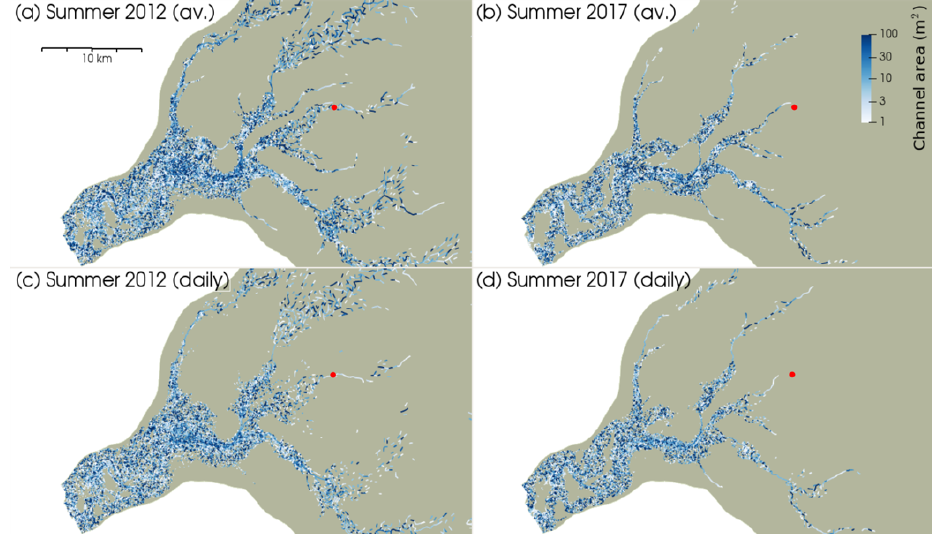
Figure 5. Summer channel network of Store. (a) SummerAverage12 model run; (b) SummerAverage17; (c) SummerDaily12; (d) Sum- merDaily17 (red dot shows S30 study site from Young et al., 2019). All the panels show the channel network at the end of the respective simulations, after 3 months of surface melting. The daily-forced runs show a less extensive channel network owing to declining surface melt towards the end of the melt